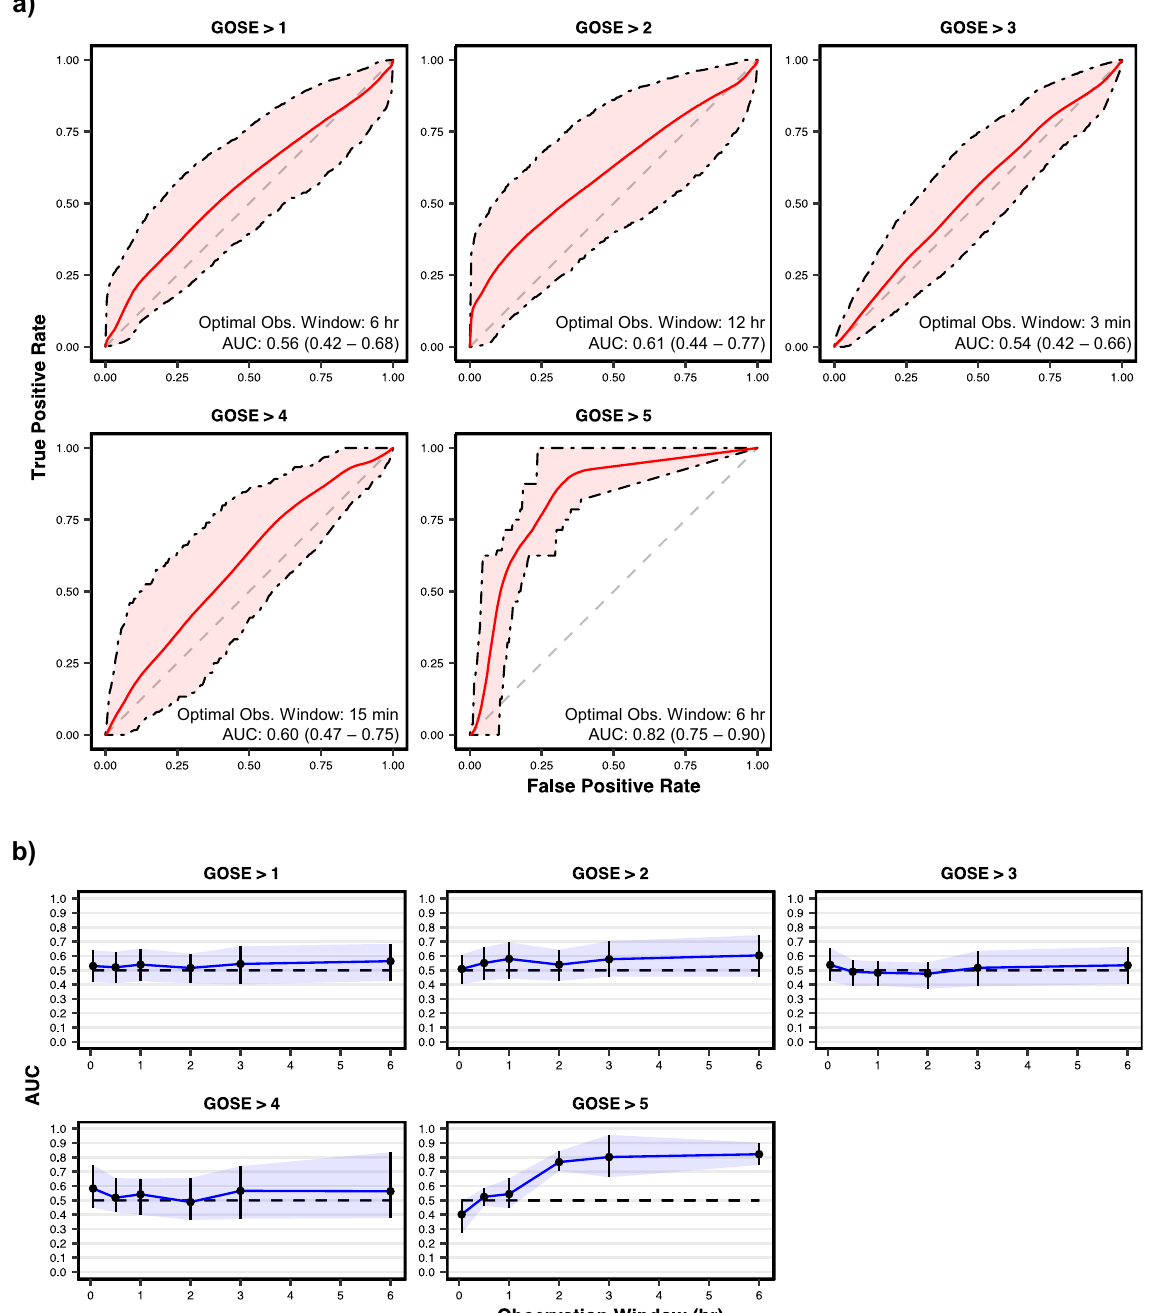
Figure 3. Discrimination performance of functional outcome at hospital discharge prediction models on validation sets. ( a ) Receiver operating characteristic (ROC) curves of models pertaining to the observation windows with the highest achieved area under the ROC curve (AUC) per each tested prediction threshold of the Glasgow Outcome Scale–Extended (GOSE). AUC corresponds to the probability that the model can correctly discriminate a randomly selected patient above the threshold from a randomly selected patient below the threshold. Shaded areas are 95% confidence intervals derived using bias-corrected bootstrapping (1000 resamples) to represent the variation across repeated cross-validation folds (5 repeats of 5 folds) and nine missing value imputations. The values in each box represent the observation window achieving the highest AUC as well as the corresponding mean AUC (with 95% confidence interval in parentheses). The diagonal dashed line represents the line of no discrimination (AUC = 0.5). ( b ) AUC vs. observation windows up to 6 h per each tested prediction threshold of the Glasgow Outcome Scale–Extended (GOSE). Points represent observation windows tested and error bars (with the associated shaded region) represent the 95% confidence interval. The horizontal dashed line corresponds to no discrimination (AUC =